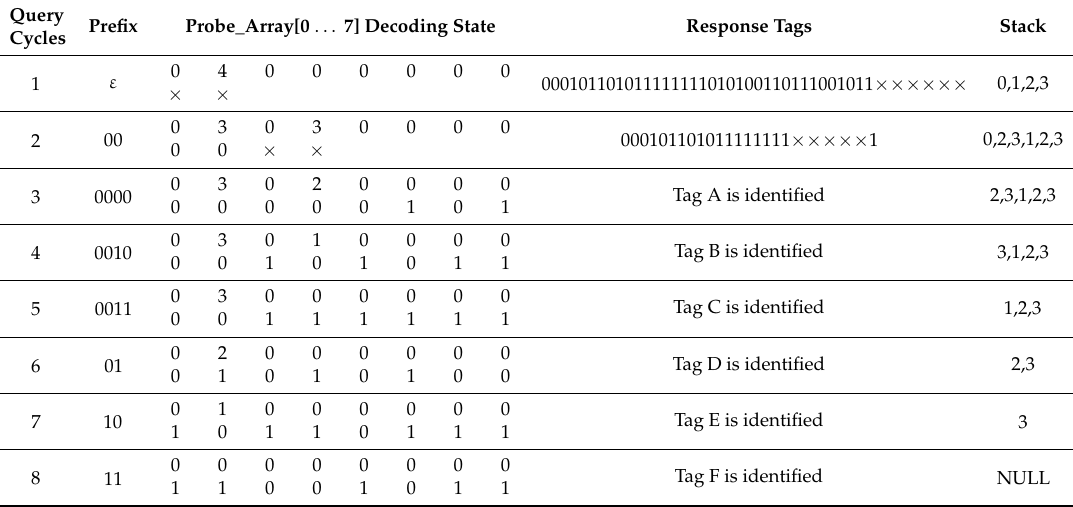
Table 6. MICT algorithm identification